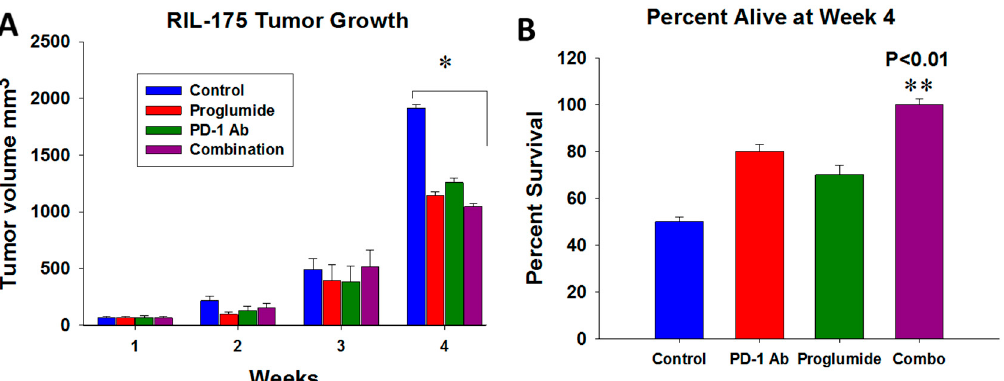
Figure 2. Effects of proglumide and PD-1Ab alone or in combination (Combo) on RIL-175 HCC tumor growth in vivo. ( A ) Tumor volumes after subcutaneous injection of 100,000 RIL-175 cells in C57BL/6 mice show a significant change in tumor volume when both proglumide and PD-1Ab were administered compared to control mice (* p < 0.05). ( B ) Percentage of mice alive after 4 weeks of treatment show a significant survival benefit in the mice treated with the combination therapy (** p <